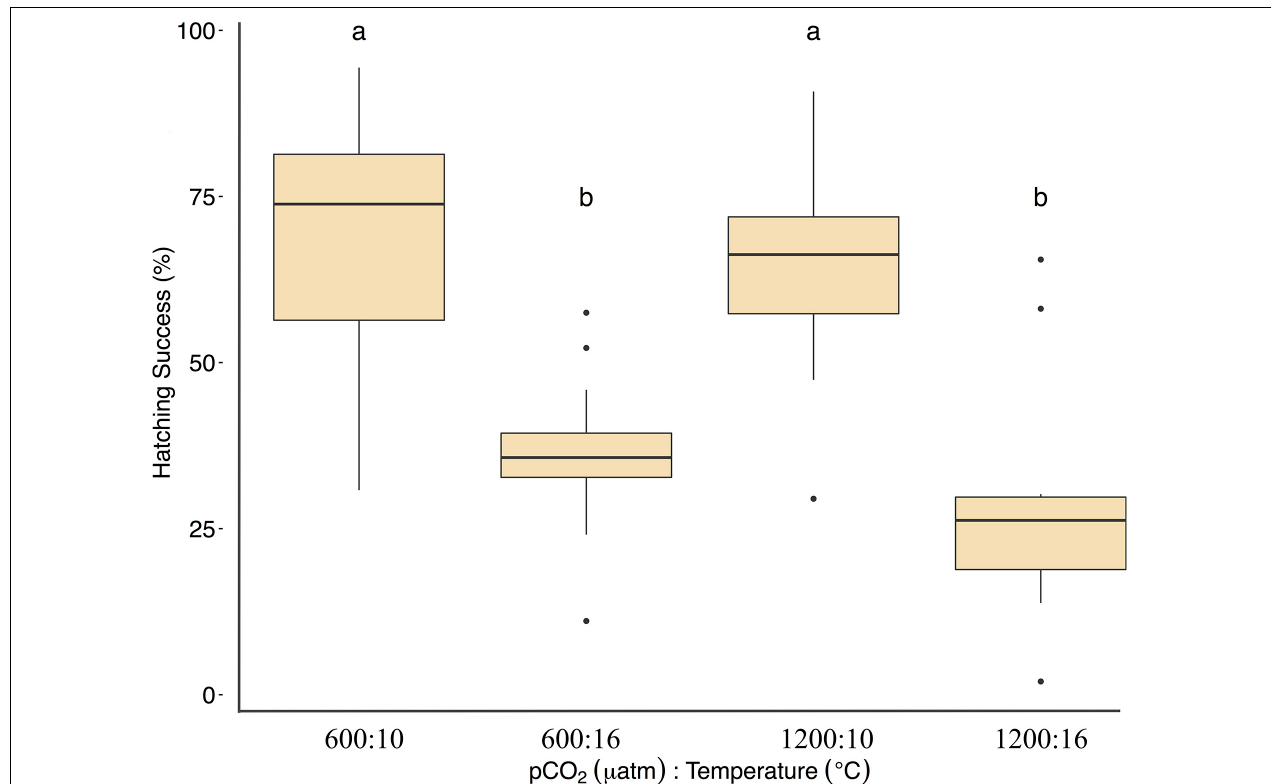
FIGURE 2 | Treatment effects on Pacific herring embryo mortality. Data represent the mean ± 1 SD of the percentage per slide, with 12 slides per 3 basins for each treatment. Lower-case letters indicate statistically different treatments based on a Tukey’s HSD post hoc comparison.